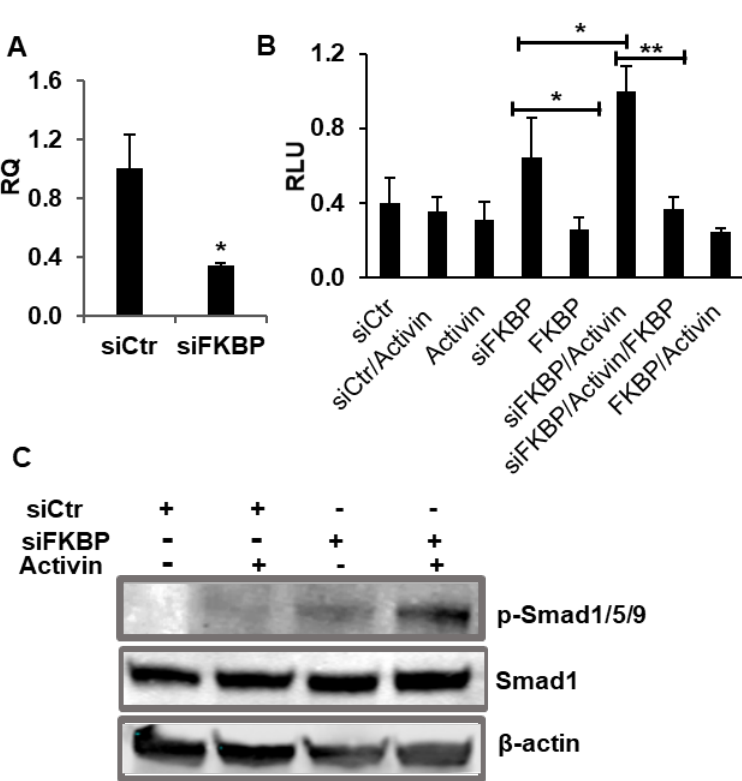
Figure 3. siRNA knockdown of FKBP12 enables ALK2 WT to mediate the activin A-induced BMP signaling in C2C12BRA cells. ( A ) Specific siRNA (siFKBP) effectively knocked down FKBP12 in the stably transfected BMP-responsive C2C12BRA cells (siCtr: scrambled siRNA). ( B ) Luciferase assay result indicated that FKBP12 knockdowns induced activin A-induced BMP signaling, whereas the overexpression of FKBP12 suppressed the activin A-induced BMP signaling in C2C12BRA cells. ( C ) Western blotting confirmed that FKBP12 knockdowns induced activin A-induced BMP signaling. Results of luciferase assay and RT-PCR assay were represented as the mean relative luciferase units (RLU) ± SEM and relative quantity (RQ) ± SEM ( n = 3, * p < 0.05, ** p < 0.01).